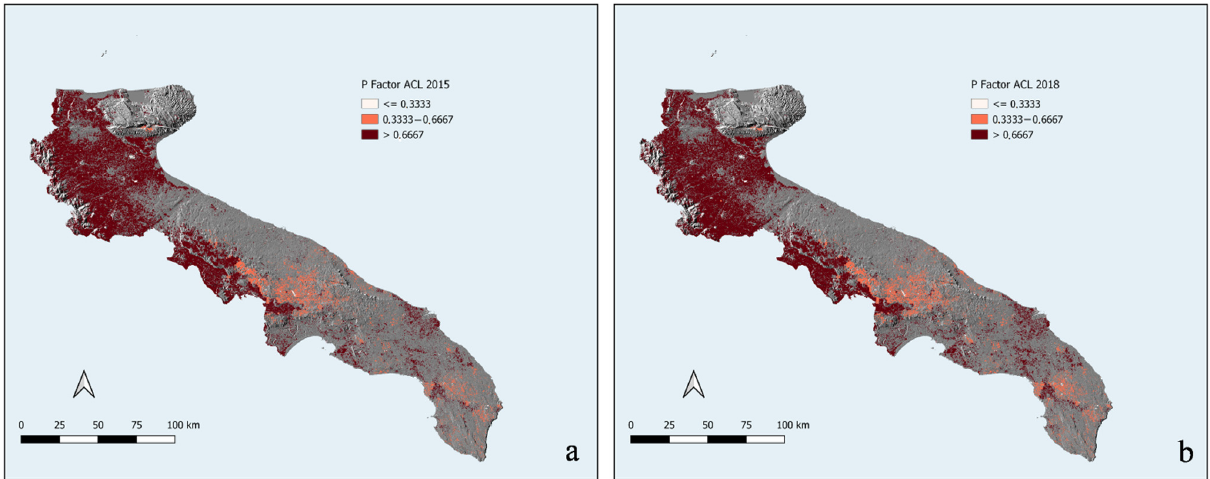
Figure 6. Soil erodibility factor ( K ) maps of the Apulia region for annual cropland in ( a ) 2015 and ( b ) 2018.